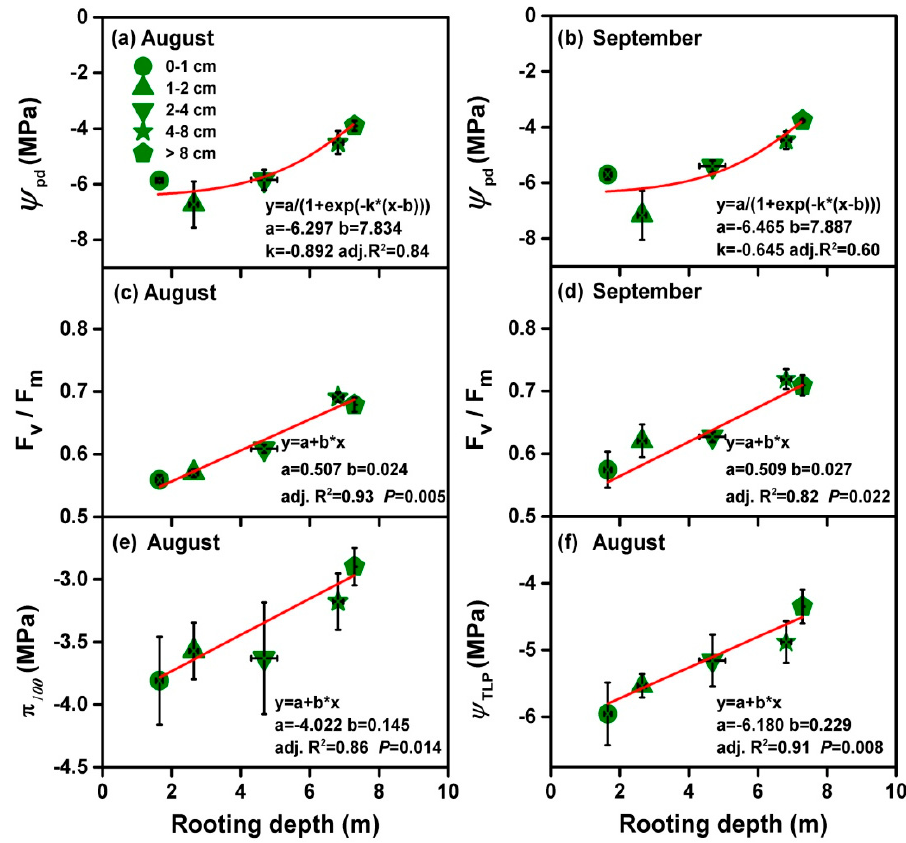
Figure 4. Predawn leaf water potential ( Ψ pd , a , b ), the maximum photochemical efficiency of photosystem II (Fv / Fm, c , d ), osmotic potential at full turgor ( π 100 , e ) and osmotic potential at turgor lost point ( Ψ TLP , f ) in relation to rooting depth. Data are mean ± 1 SE ( n = 5). .